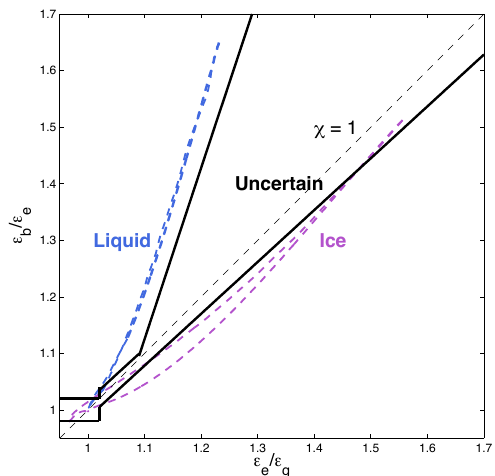
Fig. 6. An intercomparison of ratios of calculated cloud emissivi- ties at 862.5cm − 1 ( ε b ), 935.8 cm − 1 ( ε e ) and 988.4cm − 1 ( ε g ) for assumed liquid and ice clouds. Magenta and blue dashed lines de- lineate these ratios for a range of plausible parameter space in r e and τ for ice and liquid, respectively. Black lines delineate the separa- tion between diagnosed liquid, uncertain, and ice phase retrievals. The unity ratio of the axes χ = 1 is shown by the dashed black line, indicating that a rough metric for ice phased clouds is that χ <